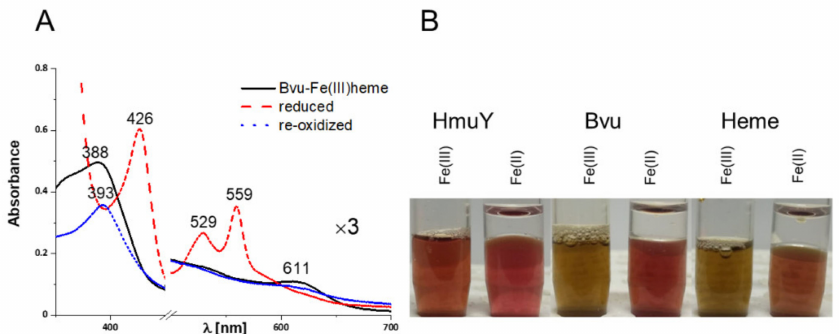
Figure 5. Spectroscopic analysis of heme binding to the purified Bvu protein. ( A ) In the analysis, 5 µ M protein in complex with heme was monitored under air (oxidizing conditions; black solid line), subsequently reduced by sodium dithionite (red dashed line), and re-oxidized by potassium ferricyanide (blue dotted line). ( B ) Colors of 100 µ M proteins complexed with heme (protein:heme molar ratio 1:1) in 20 mM sodium phosphate buffer, pH 7.4, containing 140 mM NaCl (PBS).